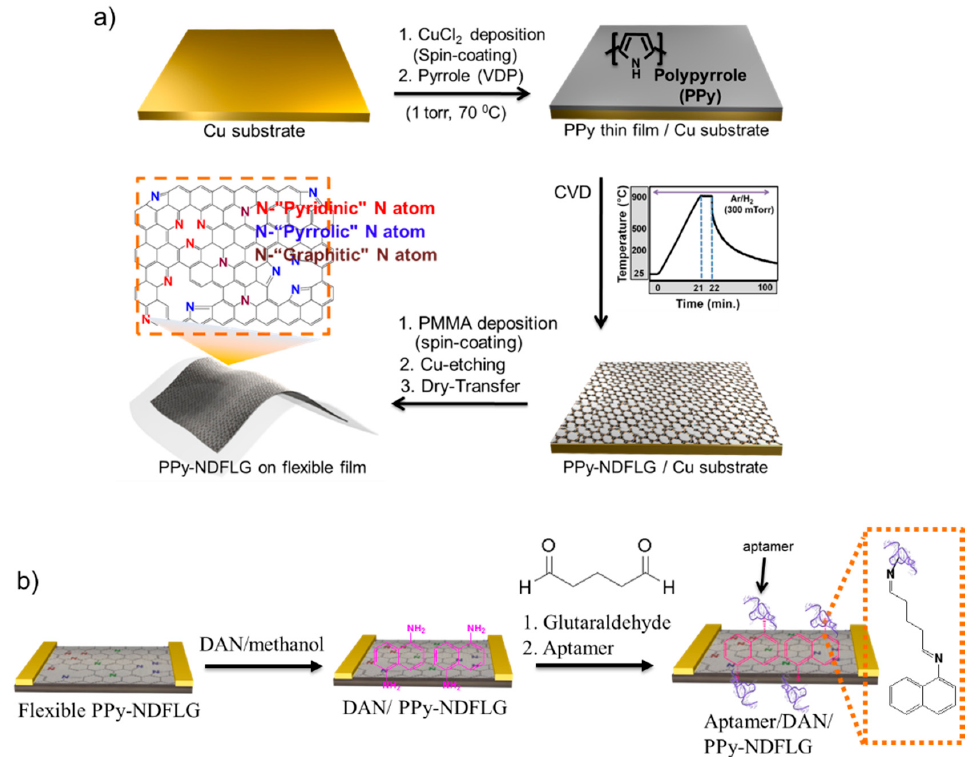
Figure 2. ( a ) Synthesis protocol of PPy-NDFLG on a flexible substrate; ( b ) Schematic illustration of the reaction steps for the fabrication of the aptasensor platform based on PPy-NDFLG conjugated with an anti-VEGF aptamer. Reprinted with permission from [11]. Copyright 2012, American Chemical Society. CVD: chemical vapor deposition; PPy-NDFLG: Polypyrrole-converted nitrogen- doped few-layer graphene; PMMA: poly(methyl methacrylate; DAN: 1,5-diaminonaphthalene; anti-